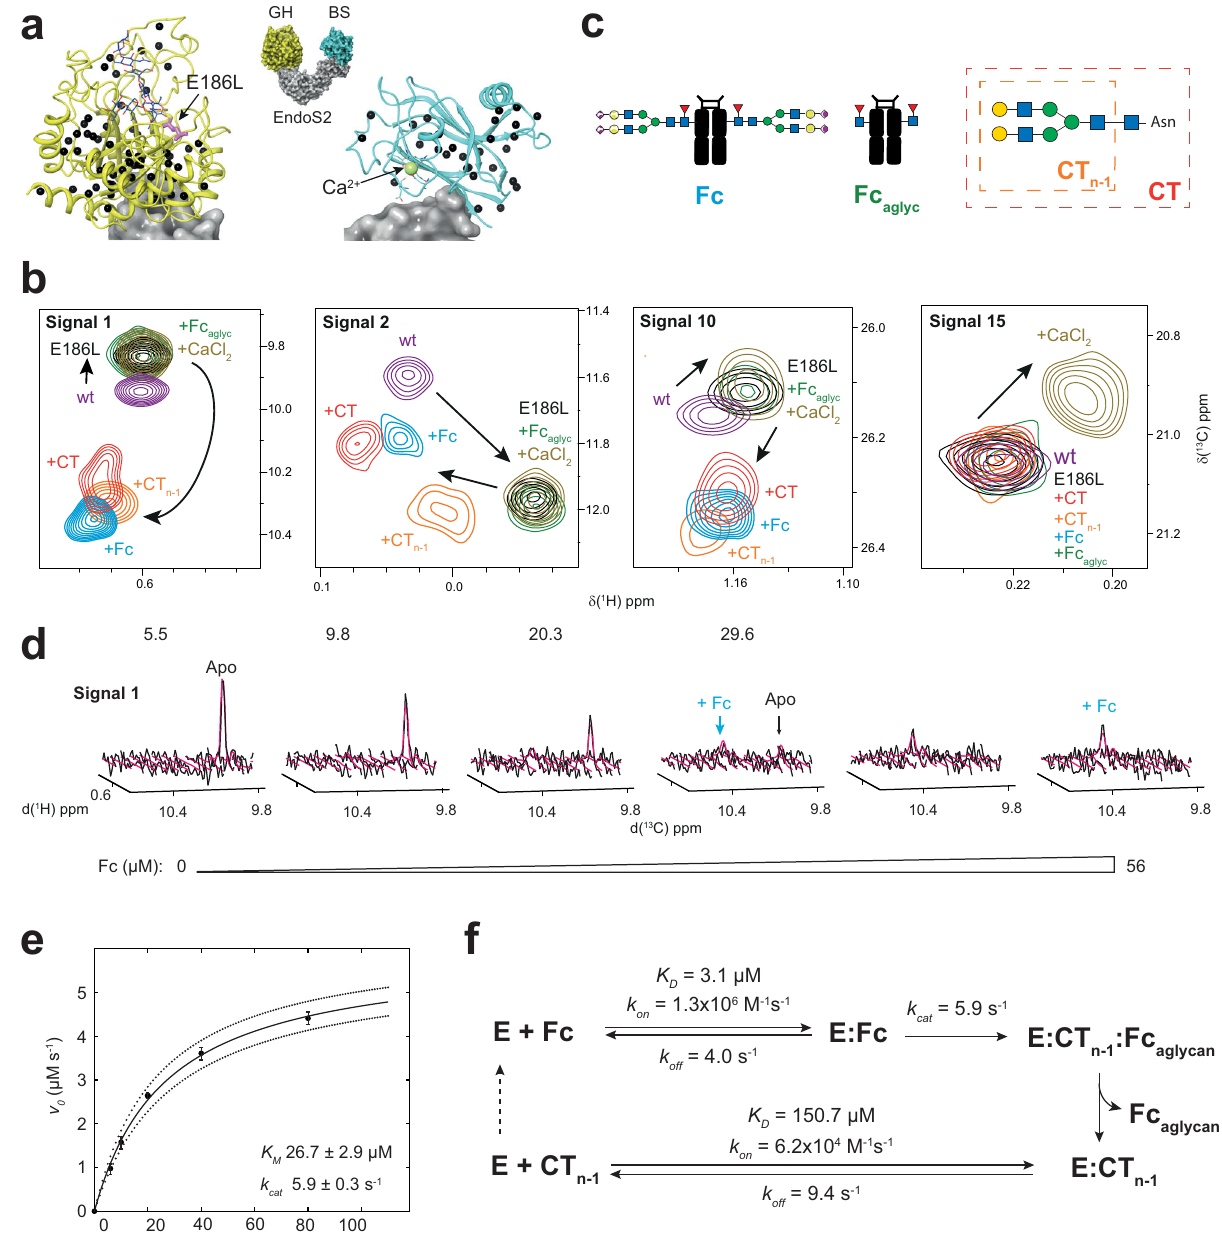
Fig. 6 | Binding af fi nity and enzyme kinetics experiments studied by NMR. a Crystal structure of EndoS2 bound to CT N -glycan and Ca 2+ (PDB code 6MDS) showing the location of the [ 13 C, 1 H 3 ]-methyl labeled probes as black spheres. Gly- coside hydrolase(GH)and β -sandwich(BS)domainsarecolored inyellowand pale blue, respectively. Mutated amino acid E186L, CT glycan and Ca 2+ ion are depicted inpink,darkblueandpalegreen. b Superimpositionofselectedregionsofmethyl- TROSY spectrashowing CSPsupon mutagenesisoratsaturationconcentrationsof different ligands. Color code corresponds to: EndoS2 (violet), EndoS2 E186L in the absence (black) and in the presence of CT (red), CT n-1 (orange), IgG1 Fc (blue) and Ca 2+ (yellow). Addition of Fc aglyc (green) induced to CSPs, suggesting very weak protein-proteininteractions.Arrowsindicatethe extentofCSPsobserved between the different protein states. c Ligands used for NMR titration experiments. IgG1 Fc region(Fc),complex-typecarbohydrate(CT)andtheproductsofglycanhydrolysis Fc aglyc and CT n − 1 , respectively. Color code like in Fig. 1. d Quantum mechanics-